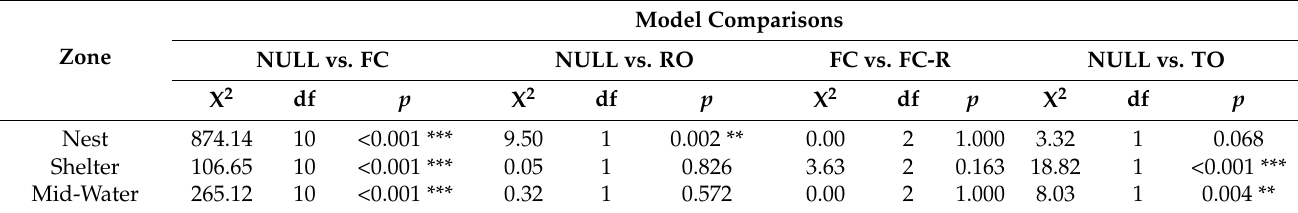
Table 3. Comparison of model performance between binomial GLMMs predicting usage of key zones.